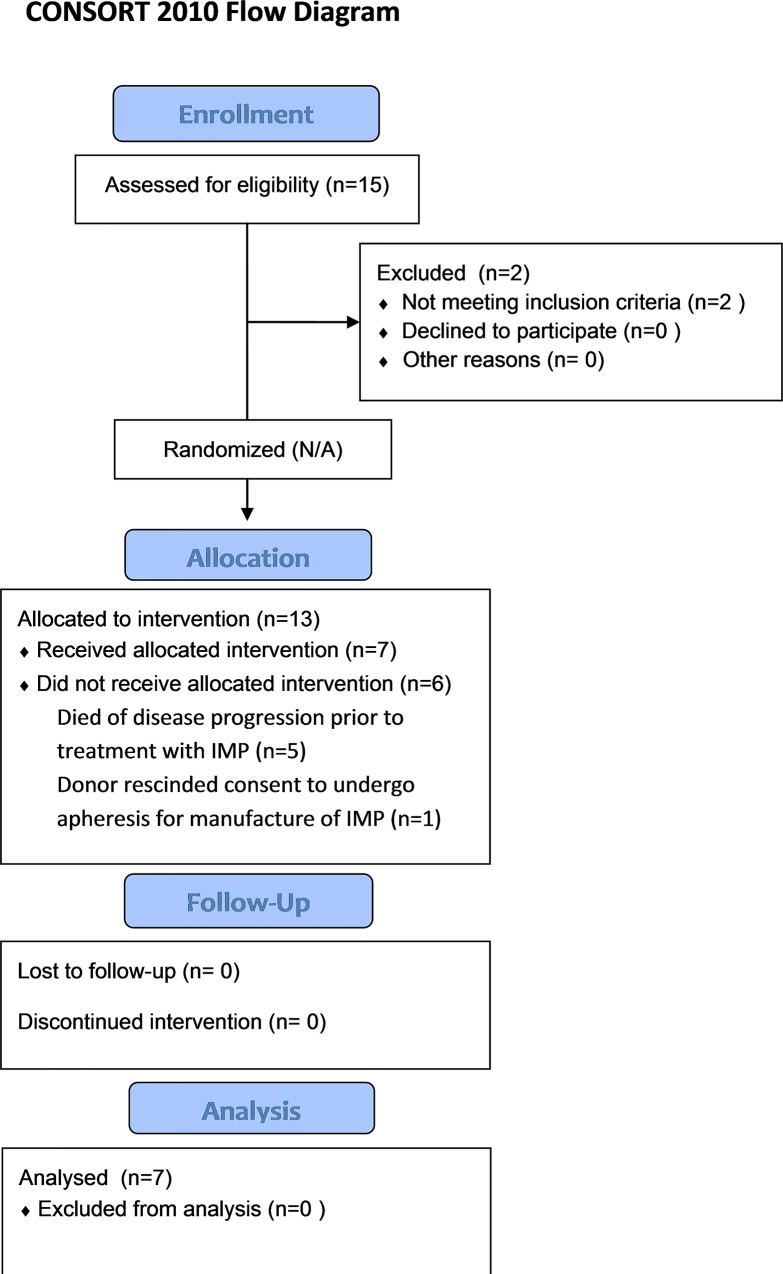
Trial enrollment summary.